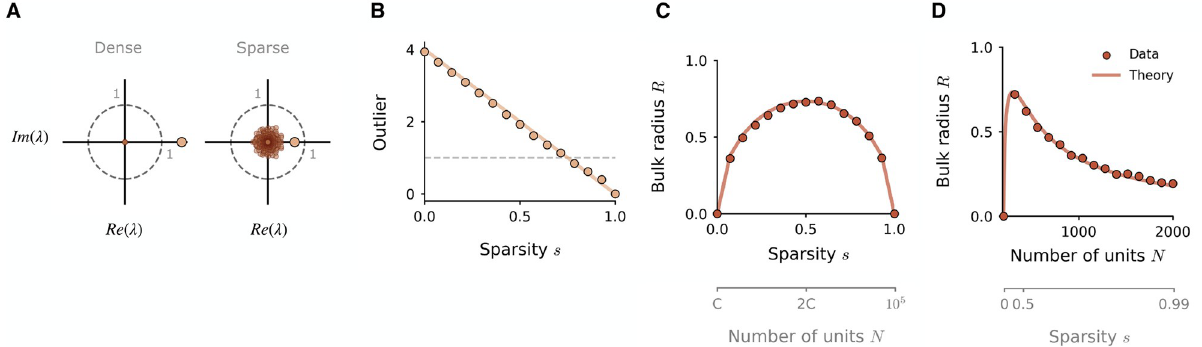
Fig 2. Influence of sparsity on the eigenspectra of rank-one networks. A : Eigenspectra of rank-one connectivity matrices of finite size, in the dense case (left) and under a sparsity of 0.5 (right). The matrix P is constructed as in (Eq 3), with parameters σ 2 = 16, σ the outlier (gold) is reduced and the bulk distribution (brown) emerges. The dashed line plots the unit circle. B, C : Impact of sparsity on two key features of the eigenspectrum of finite-size rank-one networks: B , the outlier λ 1 , and C , the spectral radius of the bulk distribution. The outlier is eventually reduced below the instability boundary of λ 1 = 1, dashed line. Sparsity is imposed as a fraction of total connections removed; σ 2 = 16, σ mn = 4 and N = 1000. D : Same as in C but for sparsity imposed by fixing C = 200 non-zero connections and increasing N ; bulk radius is plotted as a function of N . Dots: empirical measurements of outlier and bulk radius. Solid lines: theoretical prediction (Eq (9)).